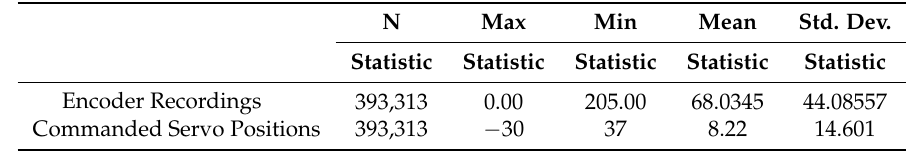
Table 5. Descriptive Statistics of Study Variables Dataset.